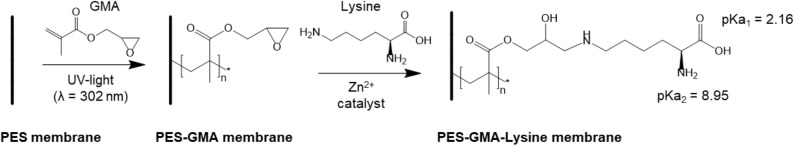
Membrane functionalization. First poly(GMA) is grafted by UV-initiated free radical polymerization. Next, lysine is covalently bound to the polymer brushes by a zinc catalyzed ring-opening reaction.